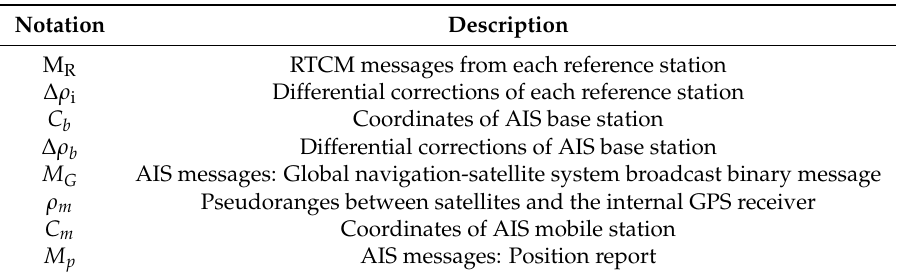
Figure 2. Block Diagram of the differential correction approach using broadcast binary messages. Table 2.